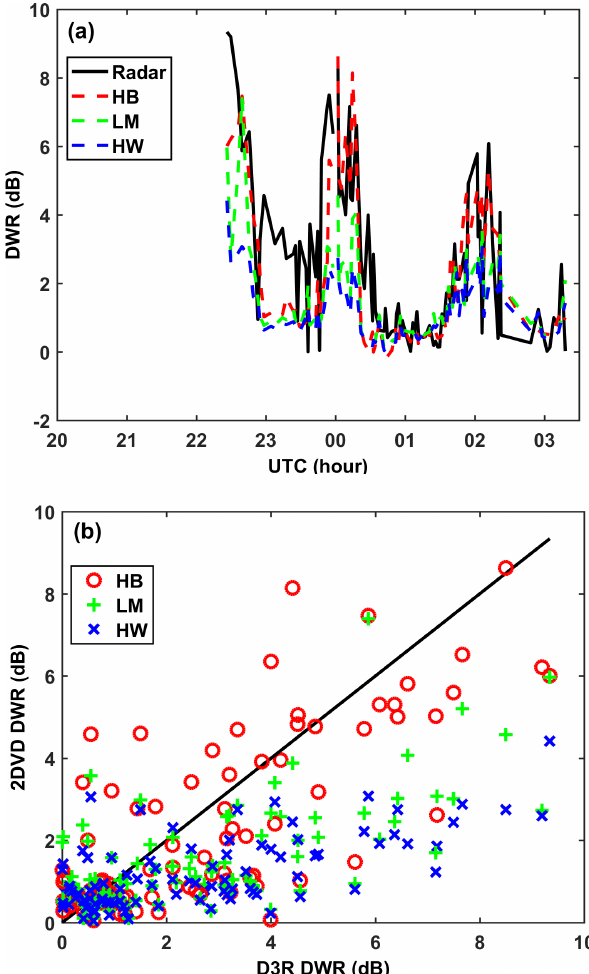
Figure 12. Comparison of the 2DVD-derived DWR using HB, LM, and HW methods with the D3R-measured DWR. Panel (a) shows the time profile of the D3R, and (b) shows the